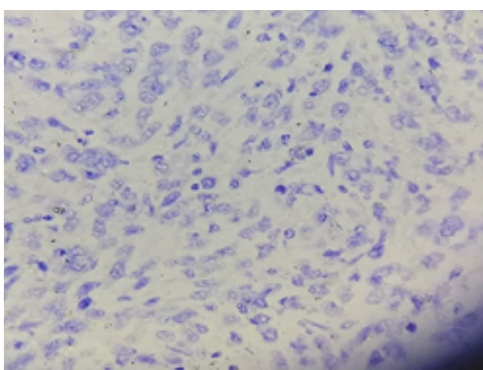
Figure 4: S100 is negative—immunochemistry (magnification x 40).